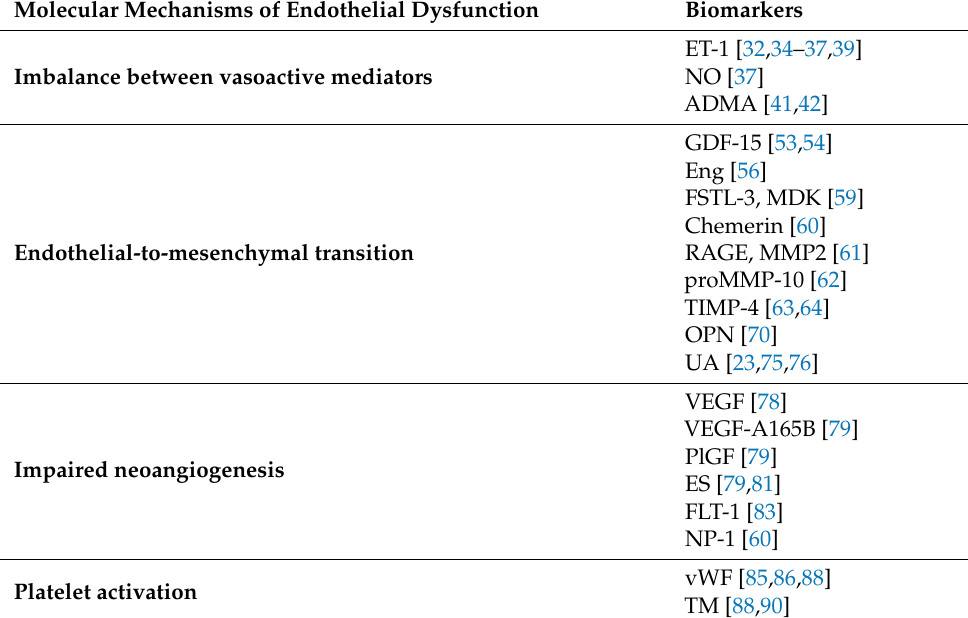
Table 1. Biomarkers of endothelial dysfunction in